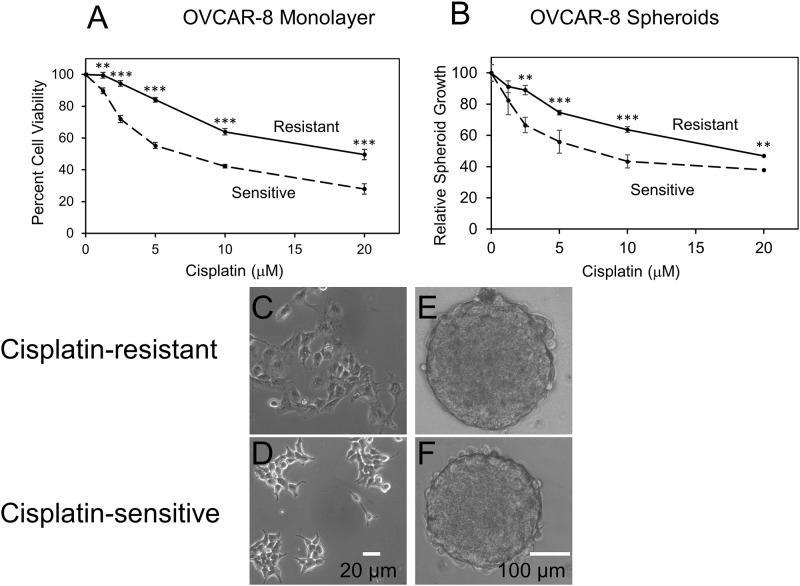
Selection of OVCAR-8 cells in increasing concentrations of cisplatin exposure leads to sustained resistance to cisplatin treatment.Cell viability of cisplatin resistant and sensitive cells grown as monolayers (A) or spheroids (B), expressed as a percentage of untreated viability, following exposure to varying concentrations of cisplatin for 96 h. Statistical comparisons were performed at each dose using a two-tailed Student’s t-test. Asterisks (**, p<0.01; ***, p<0.001) indicate significant difference in viability between cisplatin-sensitive (dashed line) and resistant cells (solid line) at the same cisplatin concentration (mean ± SE, n = 9). (C+D). Photomicrographs of cisplatin resistant (C) and sensitive (D) cells under phase contrast illumination. Resistant cells display stronger adhesion to the substrate while sensitive cells do not. Photomicrographs of spheroids from resistant (E) and sensitive (F) lines.